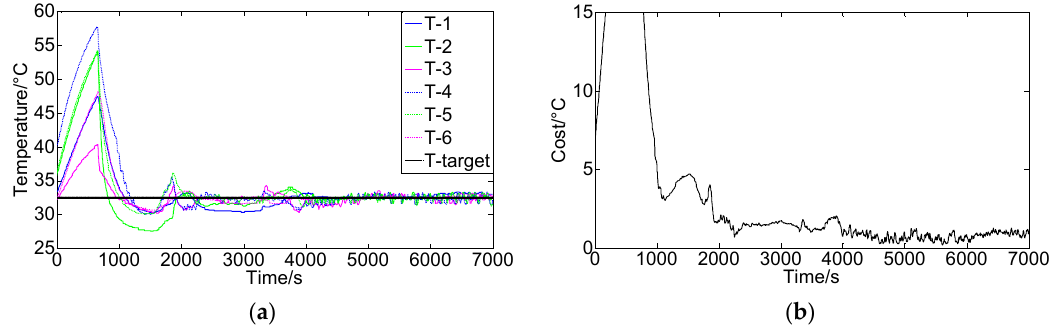
Figure 11. ( a ) Control results of the FCPIDNN controller when fan 3 failed (target temperature is 32.5 °C); ( b ) Variation of the square root of the cost function ( (cid:3493) J( n )).